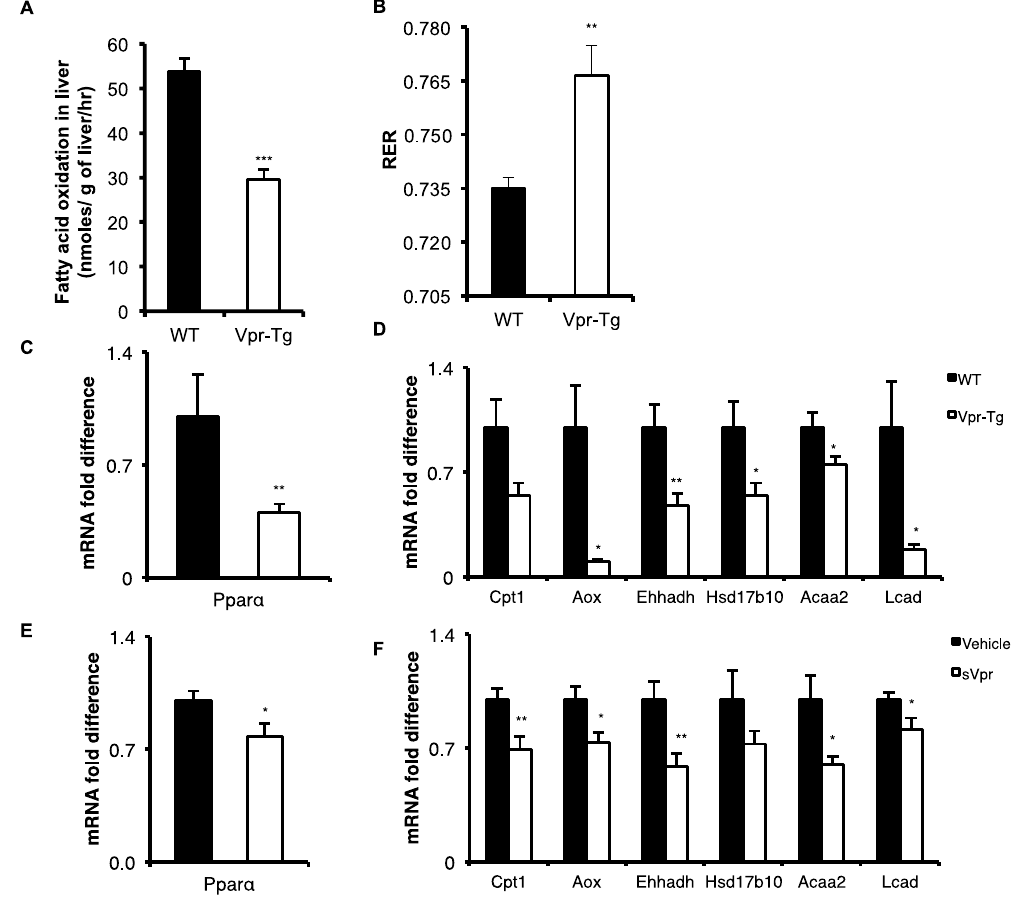
Figure 5. Impaired fatty acid oxidation and decreased mRNA levels of PPAR α -regulated oxidative genes in liver of Vpr-Tg and sVpr-treated mice. ( A ) Fatty acid oxidation was decreased in liver of Vpr-Tg compared to WT mice (P = 0.006; N = 6 per group). ( B ) Increased respiratory exchange ratio (RER) was present during the initial 4 h of fasting in Vpr-Tg compared to WT mice (N = 5–6 per group). ( C ) Ppar α mRNA level was decreased in liver of Vpr-Tg compared to WT mice (N = 5–6 per group). ( D ) mRNA levels of Aox, Ehhadh , Hsd17b10, Acaa2 and Lcad were decreased in liver of Vpr-Tg compared to WT mice (N = 5–8 per group). ( E ) mRNA level of Ppar α was decreased in sVpr-treated compared to vehicle-treated mice (N = 7 per group). ( F ) mRNA levels of Cpt1 α , Aox, Ehhadh , Acaa2 and Lcad were decreased in sVpr-treated compared to vehicle- treated mice (N = 7 per group). Values are mean ± SE. * P < 0.05, ** P < 0.01, *** P <